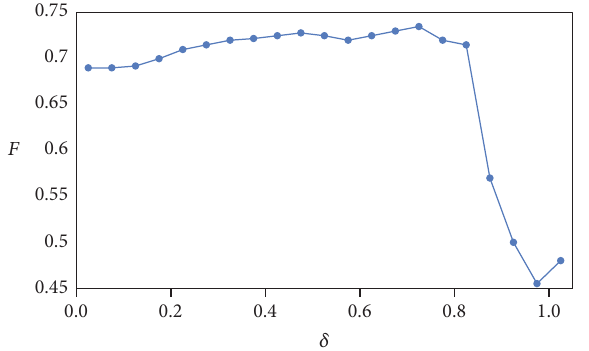
Figure 6: Selection of threshold value 𝛿